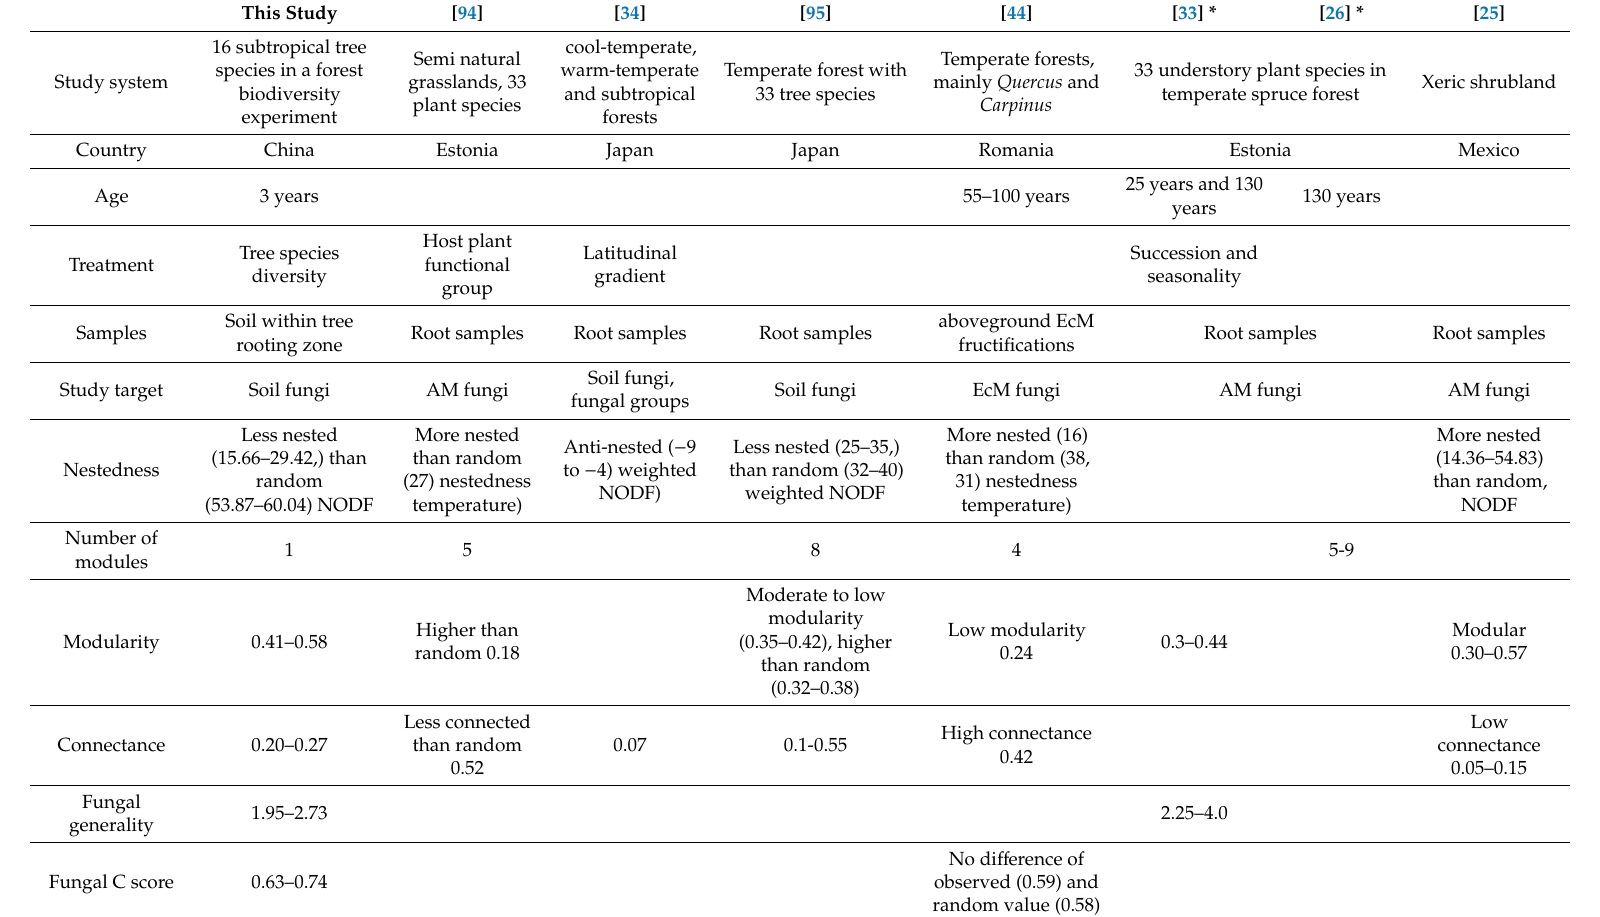
Table 3. Network metrics reported in previously published plant-fungal network